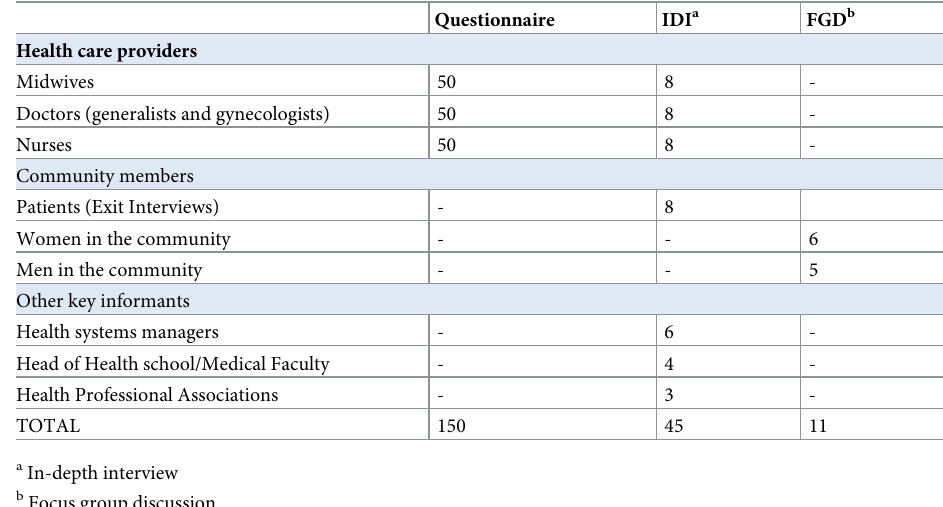
Table 1. Data collection methods and sample